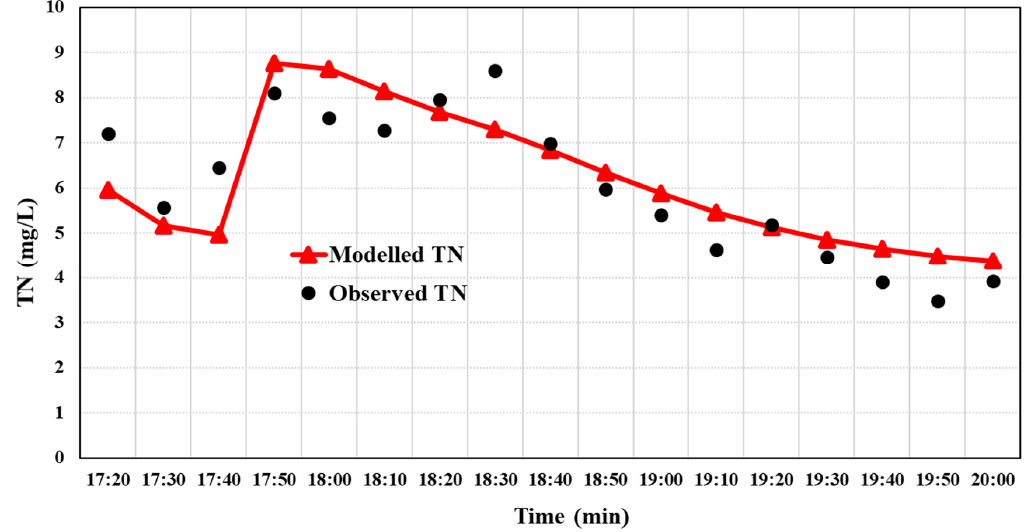
Figure 8. Total nitrogen (TN) calibration result.